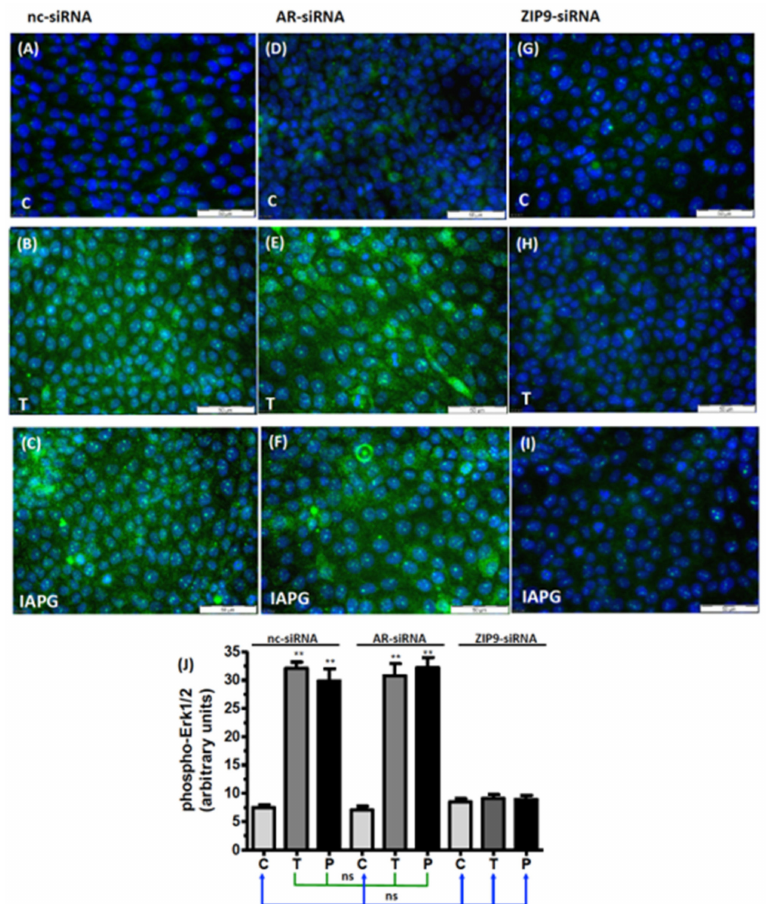
Figure 6. Immunofluorescence of phospho-Erk1/2 in PASC1 cells. Incubation with vehicle (C), 10 nM testosterone (T), or 10 µ M IAPG (P) was carried out for 24 h. Nuclei are stained blue, and phospho-Erk1/2 is represented by green fluorescence. ( A – C ) Phospho-Erk1/2 in cells treated with nc-siRNA; ( D – F ) phospho-Erk1/2 in cells treated with AR-siRNA; ( G – I ) phospho-Erk1/2 in cells treated with ZIP9-siRNA. ( J ) Statistical analysis of green fluorescence shown in panels A–I ( n = 3 × 25; means ± SEM; ** p ≤ 0.01; ns = not